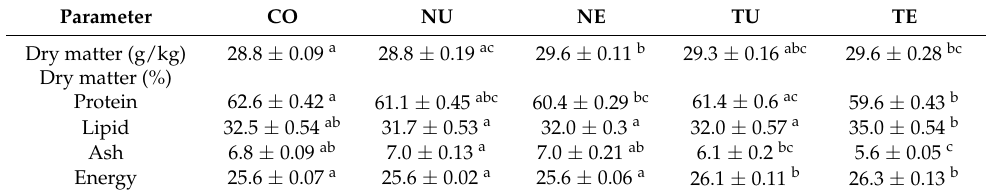
Values are expressed as mean ± sem (n = 4 replicates). Values in the same row with different superscript letters ( a,b,c ) indicate significant differences ( p < 0.05).